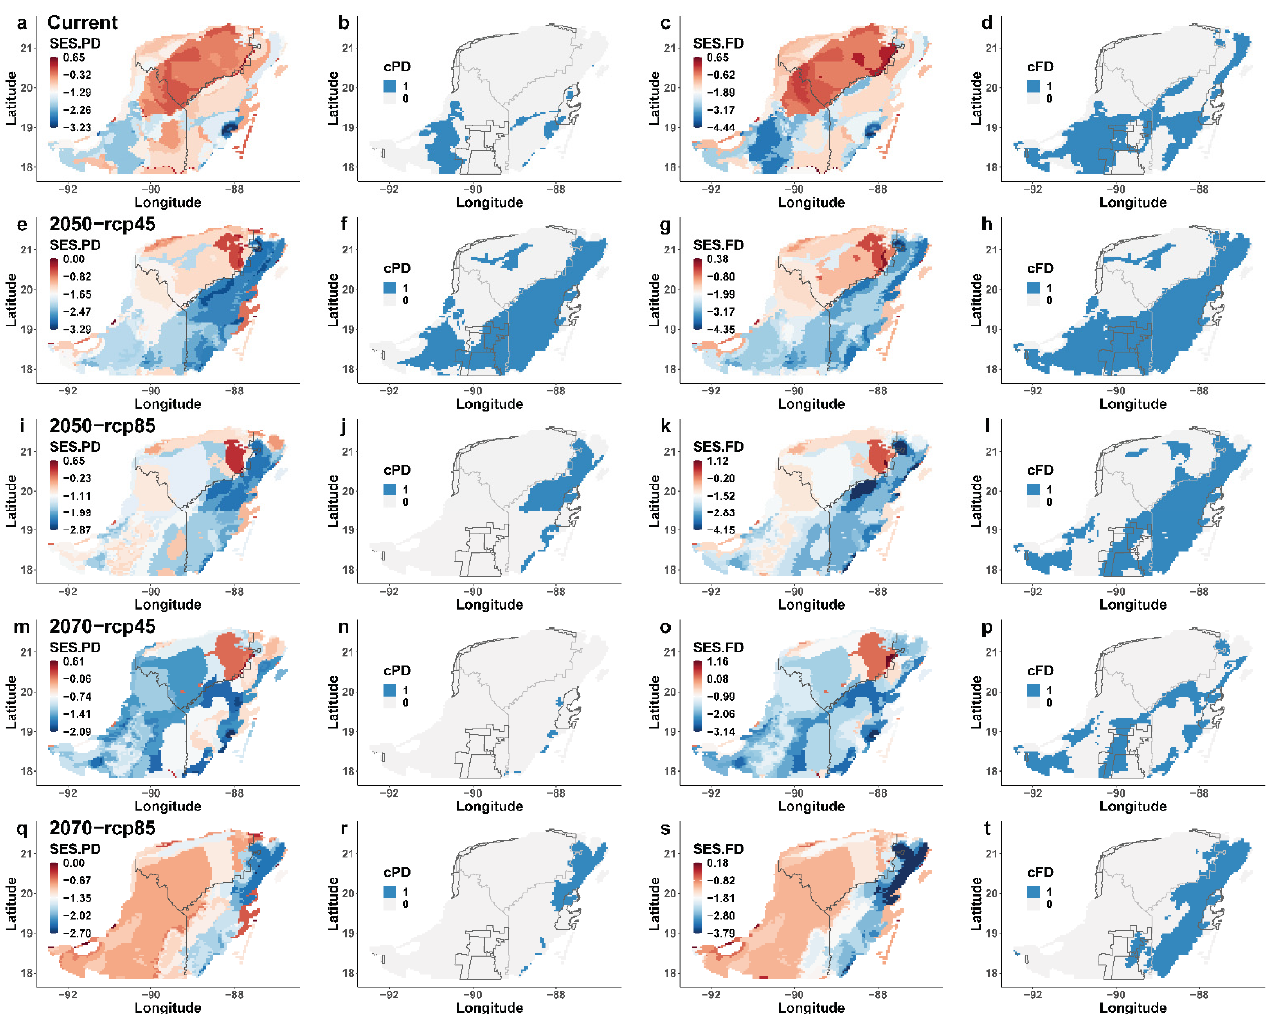
Figure 4. Raw standardized effect size (SES) values for phylogenetic and functional diversities (SES.PD: ( a , e , i , m,q ) and SES.FD: ( c , g , k , o , s )). The identified and reclassified significant values depicting phylogenetic or functional clustered assemblages, cPD and cFD, respectively, are shown in blue. cPD: ( b , f , j , n , r ); cFD: ( d , h , l , p , t ).